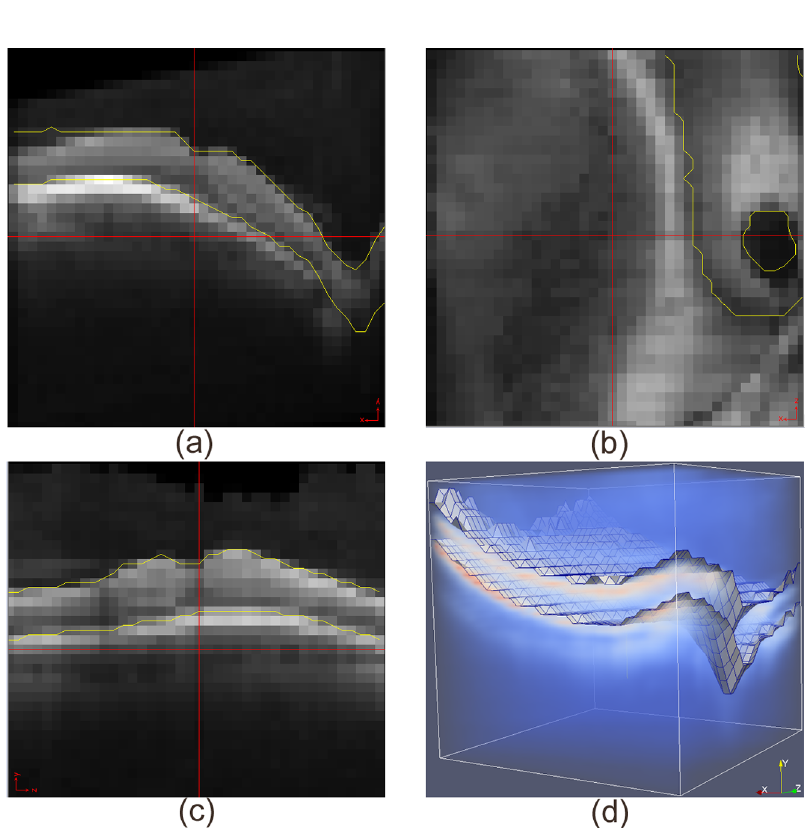
Figure 13. Segmentation of OCT volume with conventional graph search. (a) Cross section of one B-scan; (b) Top view; (c) Cross section perpendicular to B-scan; (d) 3D volume rendering.